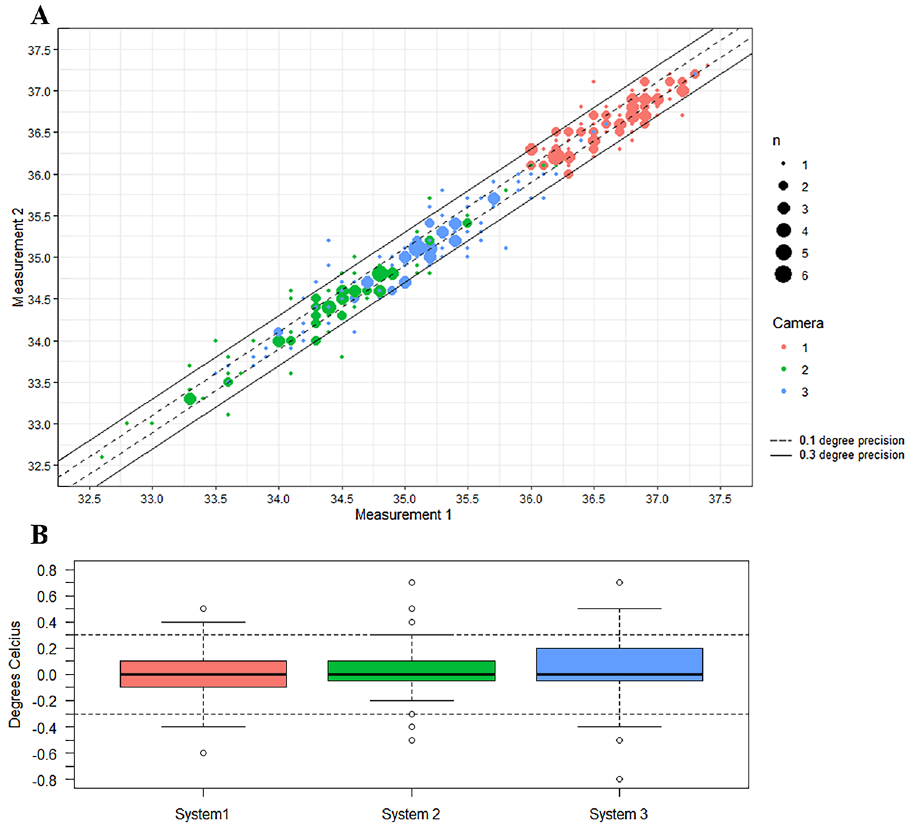
Figure 2. Repeated measurements precision test results. ( A ) A bubble-plot which displays the first measurement against the second. The dotted lines is the range in which a system with 0.1 °C of precision would fit, the continuous lines are the range in which a system with 0.3 °C of precision would fit. ( B ) A boxplot of the difference between the first and second measurement clearly displaying the quartile ranges and the outliers from each system.